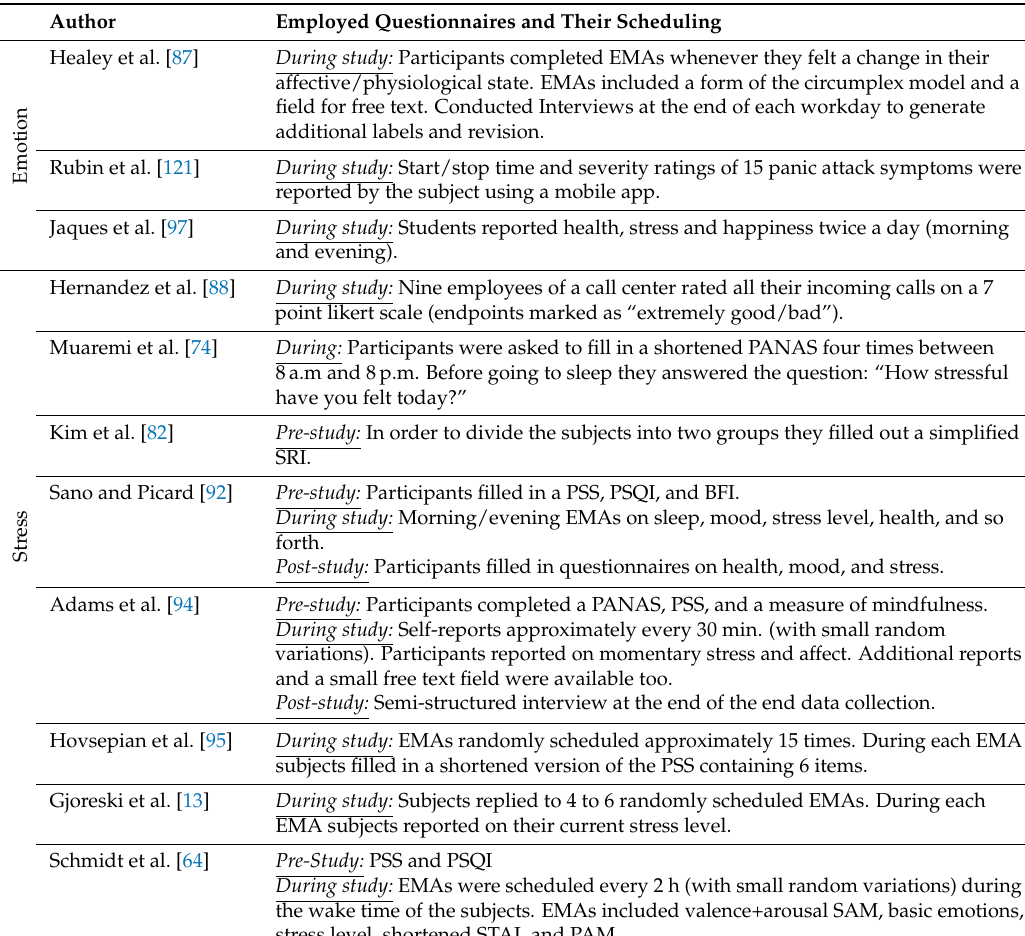
Table 6. Questionnaires employed during recent field studies, focusing on the applied scheduling (Pre-, During or